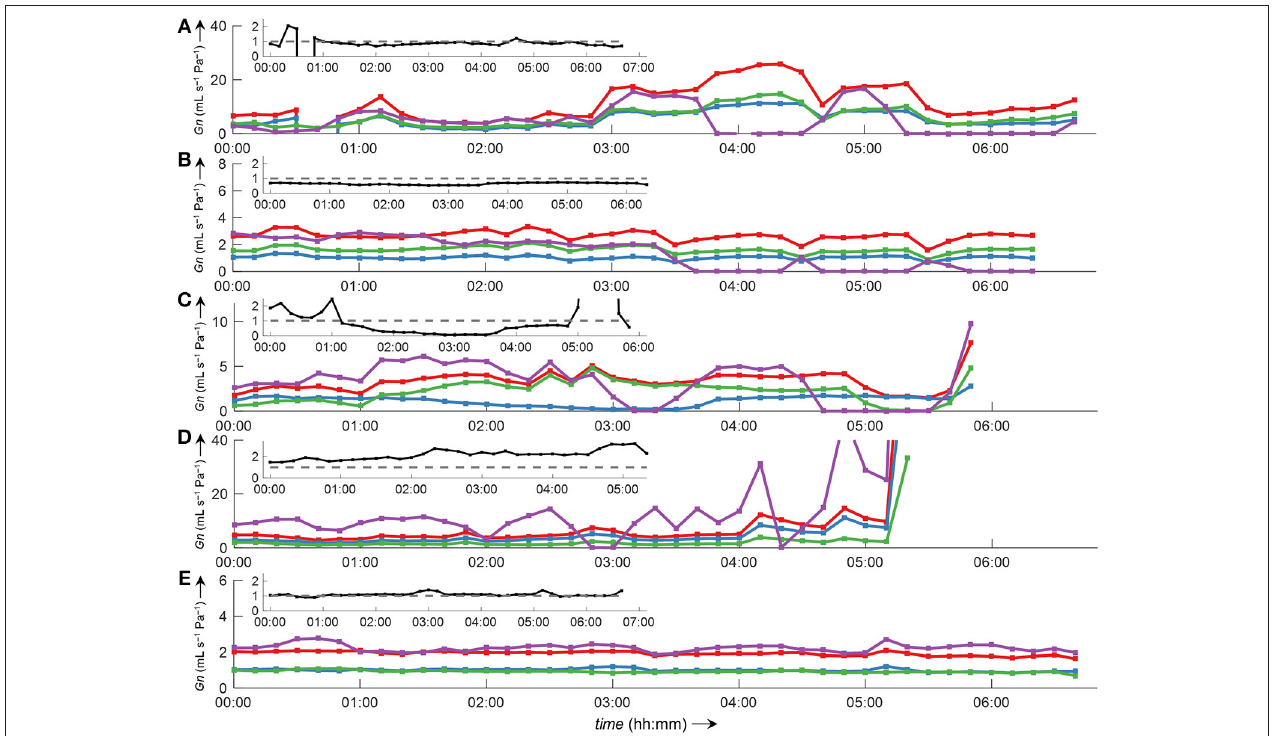
FIGURE 11 | Bilateral conductance curves obtained by algorithm 3 in comparison to conductance obtained from a flow meter during overnight measurements of all five datasets analyzed in this study (A–E) . The data were evaluated as an average of 10-min intervals. Overlay of left conductance ( Gn L , blue line), right conductance ( Gn R , green line), total conductance ( Gn L R , red line), and conductance derived from a flow meter ( Gn PNT , purple line). Outliers and gaps in the curves (missing + conductance values) result from displacement of catheters and/or the face mask with attached flow meter during body movements. The insets show the ratio Gn L / Gn R (black